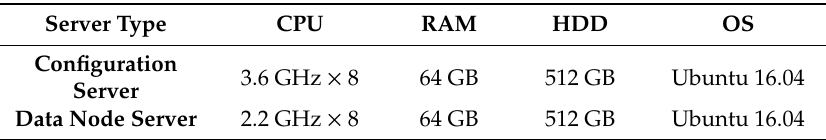
Table 1. Specification of